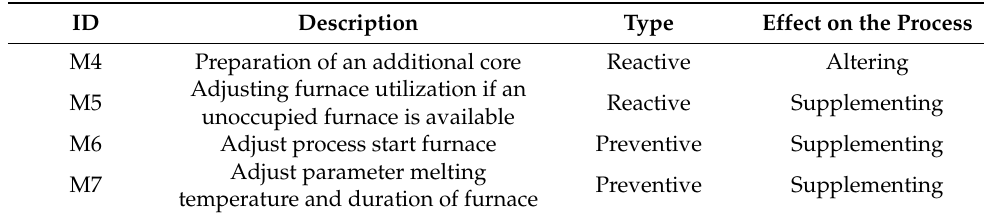
Table 6. Catalog with four categorized